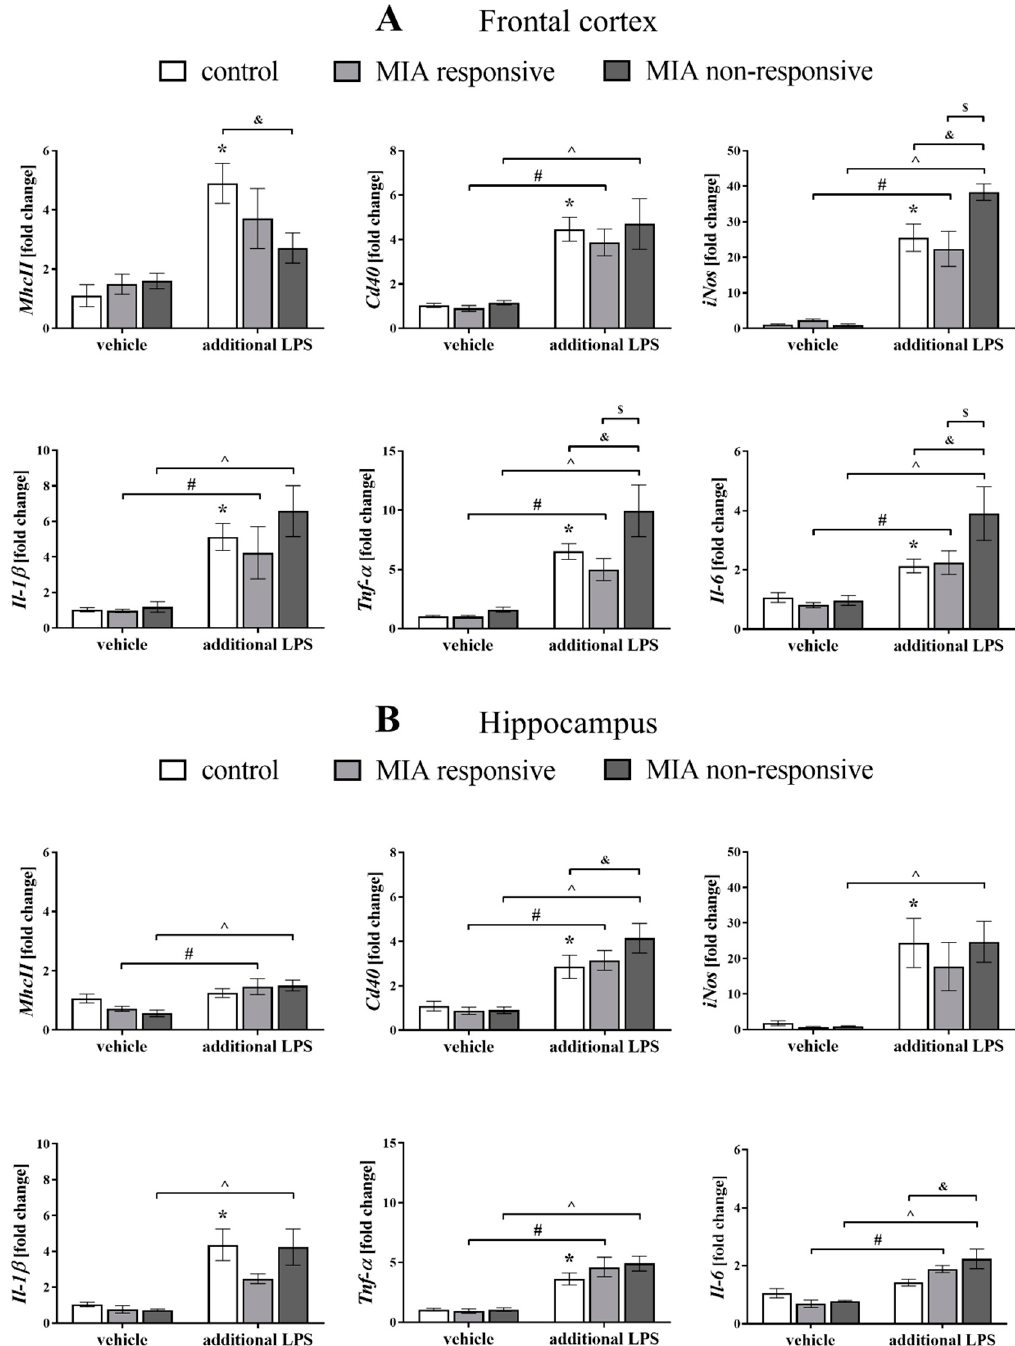
Figure 9. The effect of MIA and the additional acute challenge with LPS on the gene expression of the pro-inflammatory microglial markers: MhcII , Cd40 , iNos , Il-1 β , Tnf- α and Il-6 in the frontal cortices ( A ) and hippocampi ( B ) of male Sprague-Dawley offspring at PND120. The mRNA levels were measured using qRT-PCR with n = up to 10 in each group. The results are presented as the average fold change ± SEM. * p < 0.05 vs. control + vehicle, # p < 0.05 vs. MIA responsive + vehicle, ^ p < 0.05 vs. MIA non-responsive + vehicle, $ p < 0.05 vs. MIA responsive + LPS, & p < 0.05 vs. control + LPS.